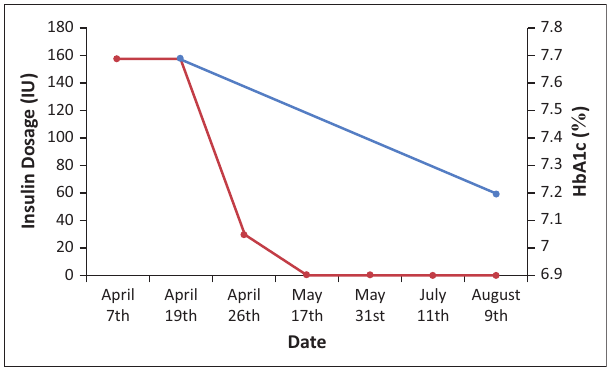
FIGURE 1: Change in insulin dosage and glycosylated haemoglobin over the course of